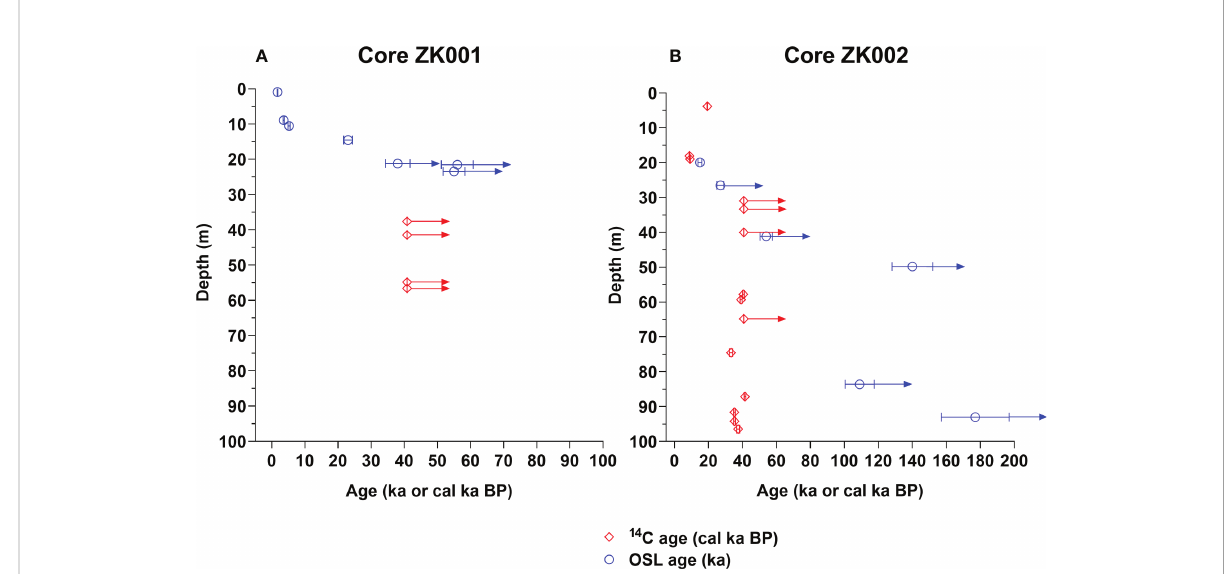
FIGURE 3 Comparison between 14 C ages and OSL ages obtained from (A) core ZK001 and (B) core ZK002. Red open rhomb represents 14 C age, red open rhomb with an arrow represents in fi nite 14 C age, blue open rotundity represents OSL age, and blue open rotundity with an arrow represents minimum OSL age. Calibrated 14 C ages are reported in cal ka BP and OSL ages are reported in